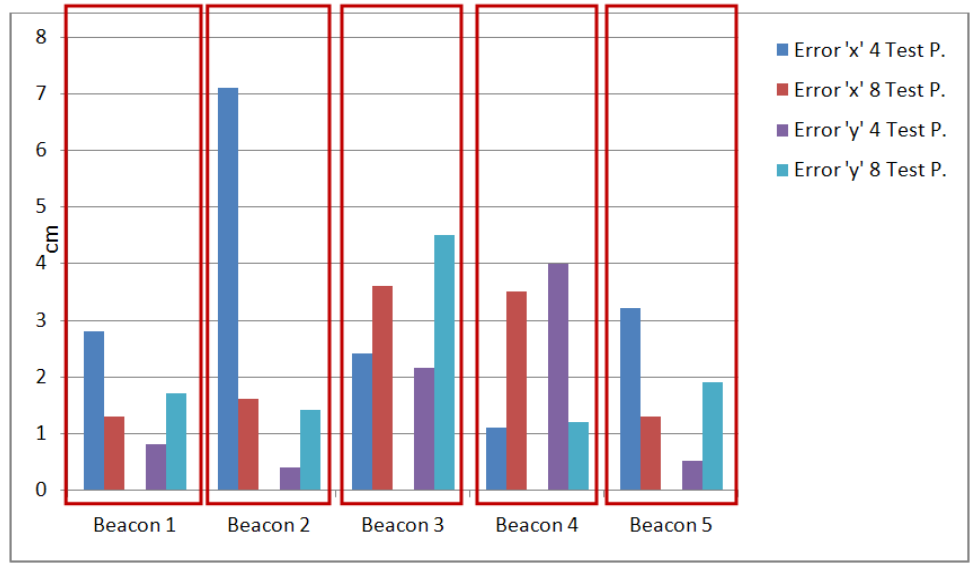
Figure 11. Average absolute error in every component for the calibrated beacons (hyperbolic